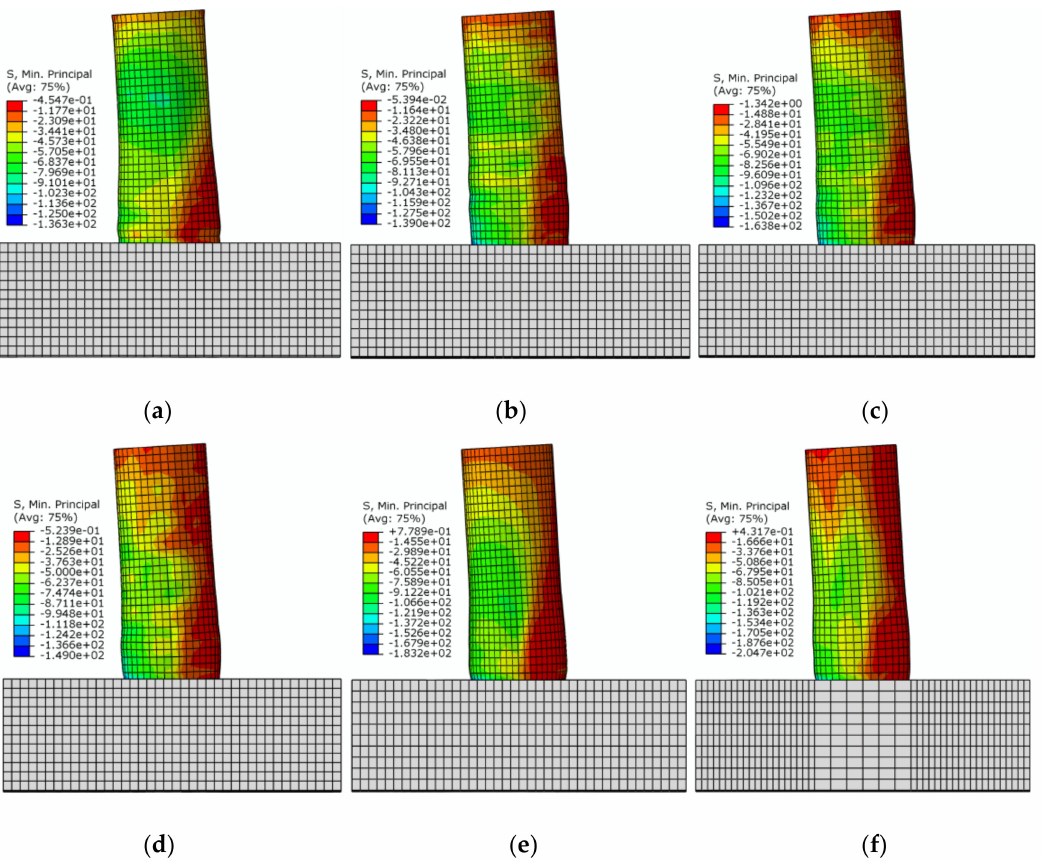
Figure 19. Min principal stress contour plot of concrete. ( a ) CFST-N; ( b ) CFST-HS; ( c ) CFST-VS; ( d ) CFST-SR; ( e ) CFST-DT; and ( f ) CFST-MC.